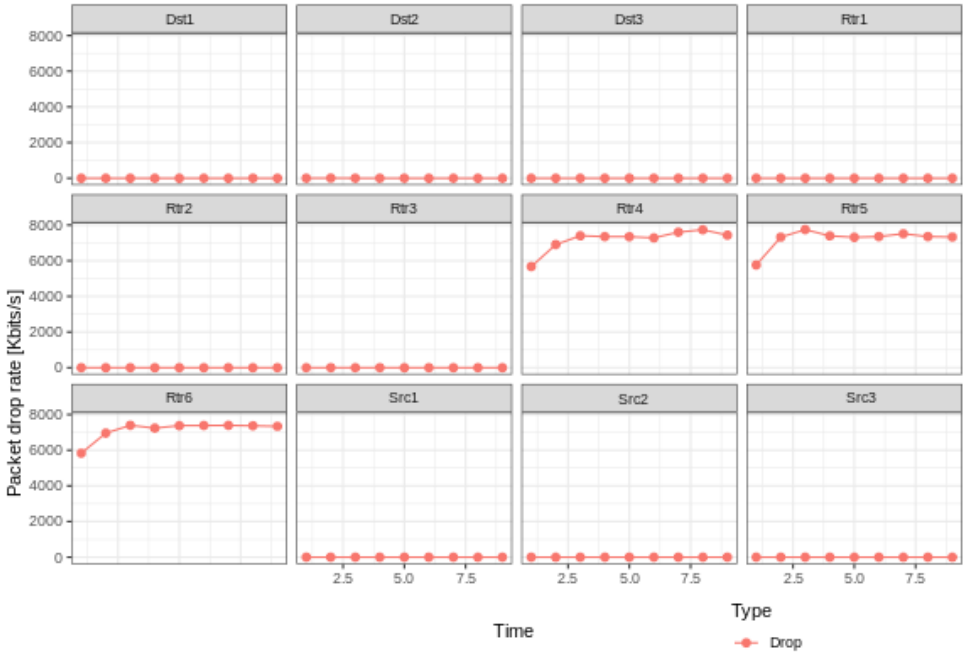
Figure 9. NDN network throughput.